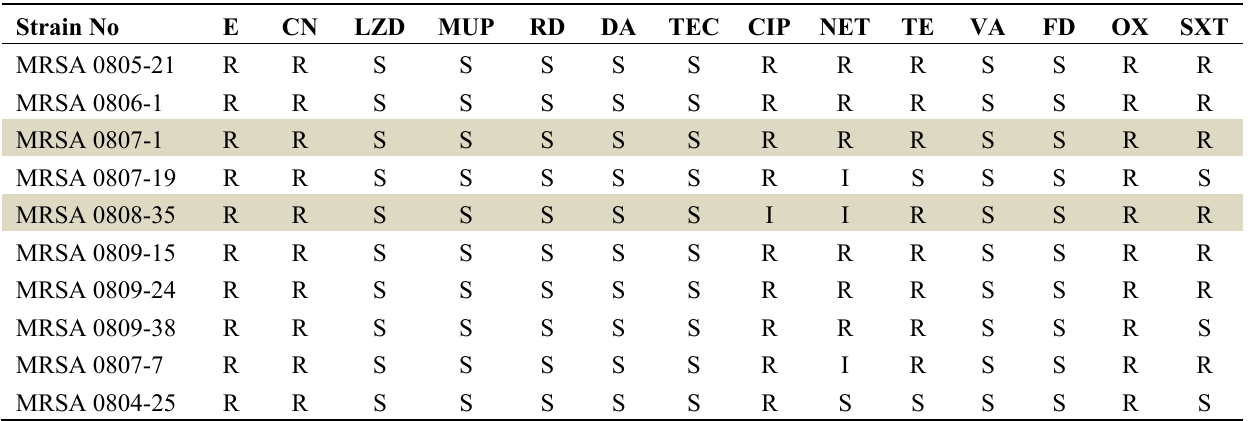
Table 6. Antibiogram of the ten clinical strains of MRSA used in the antibacterial analysis. Strain No E CN LZD MUP RD DA TEC